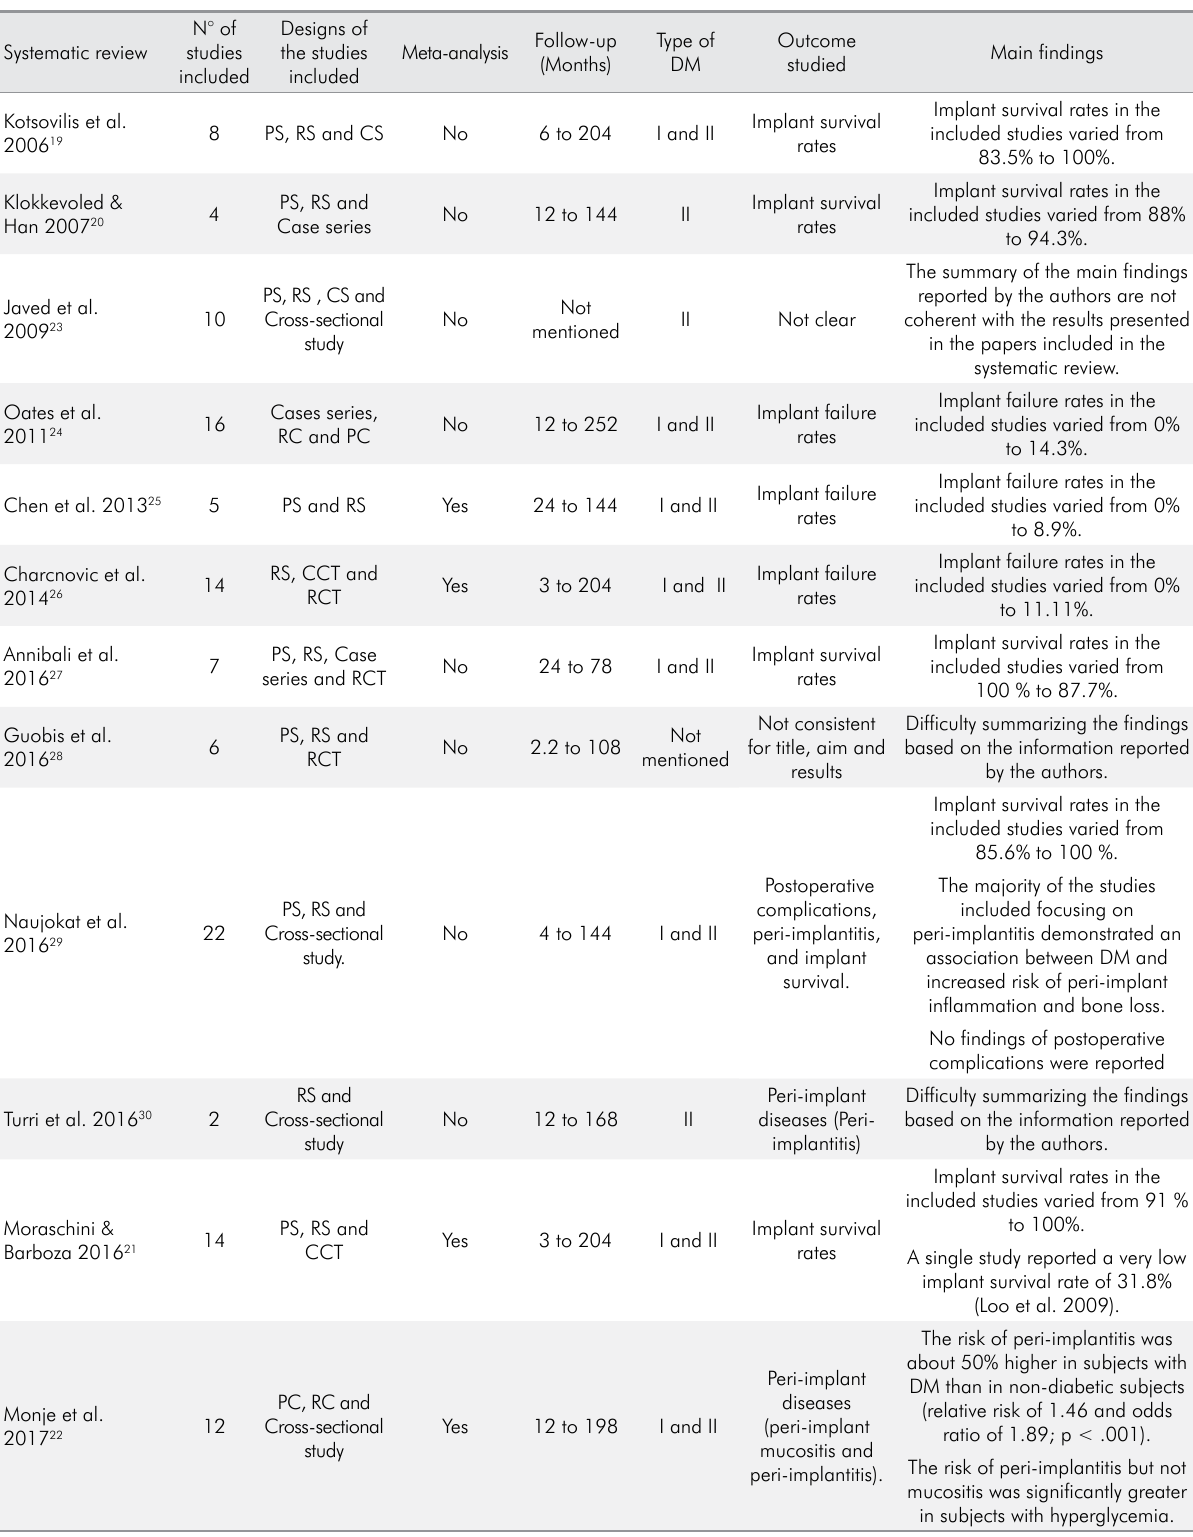
Table 2. Characteristics and main findings of the systematic reviews